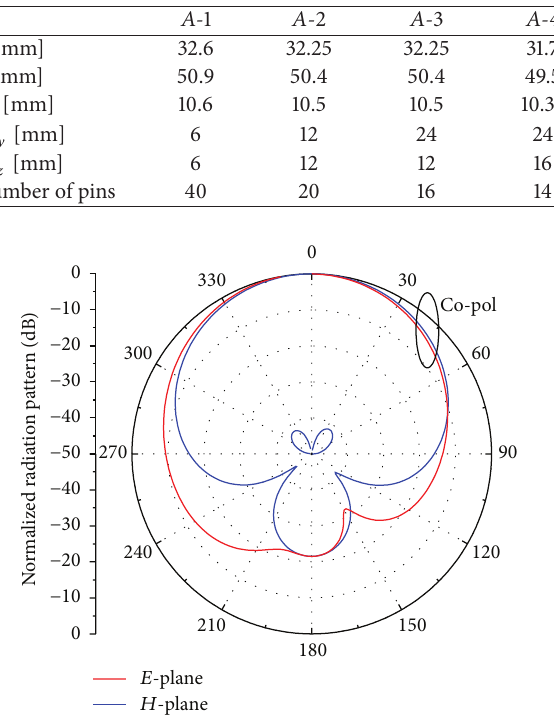
Figure 8: Radiation patterns of the CBHM